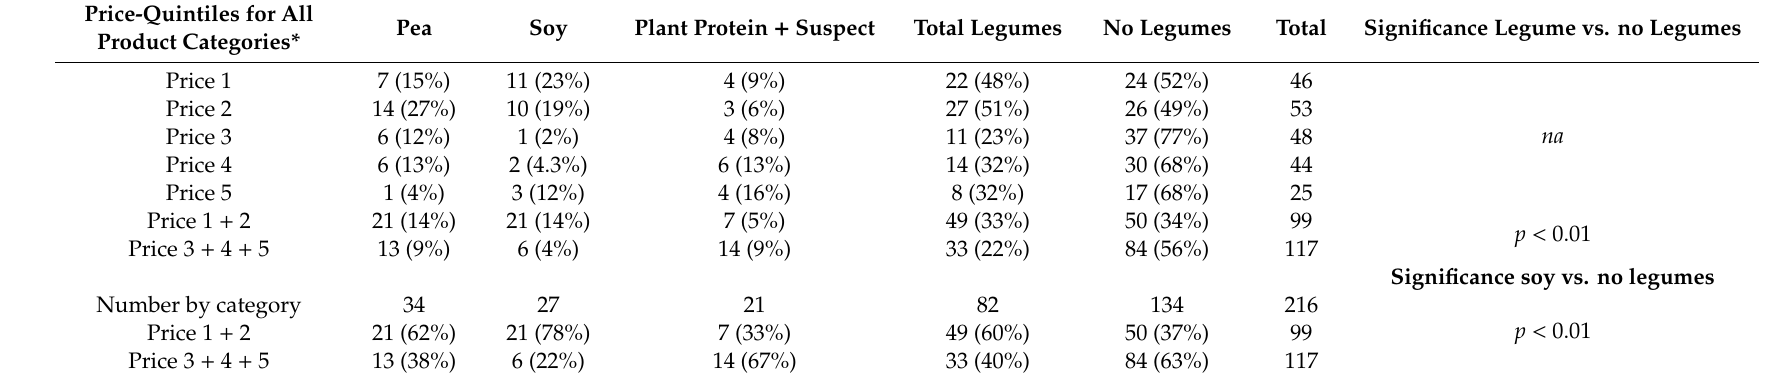
Table 3. Price analysis per foodstu ff